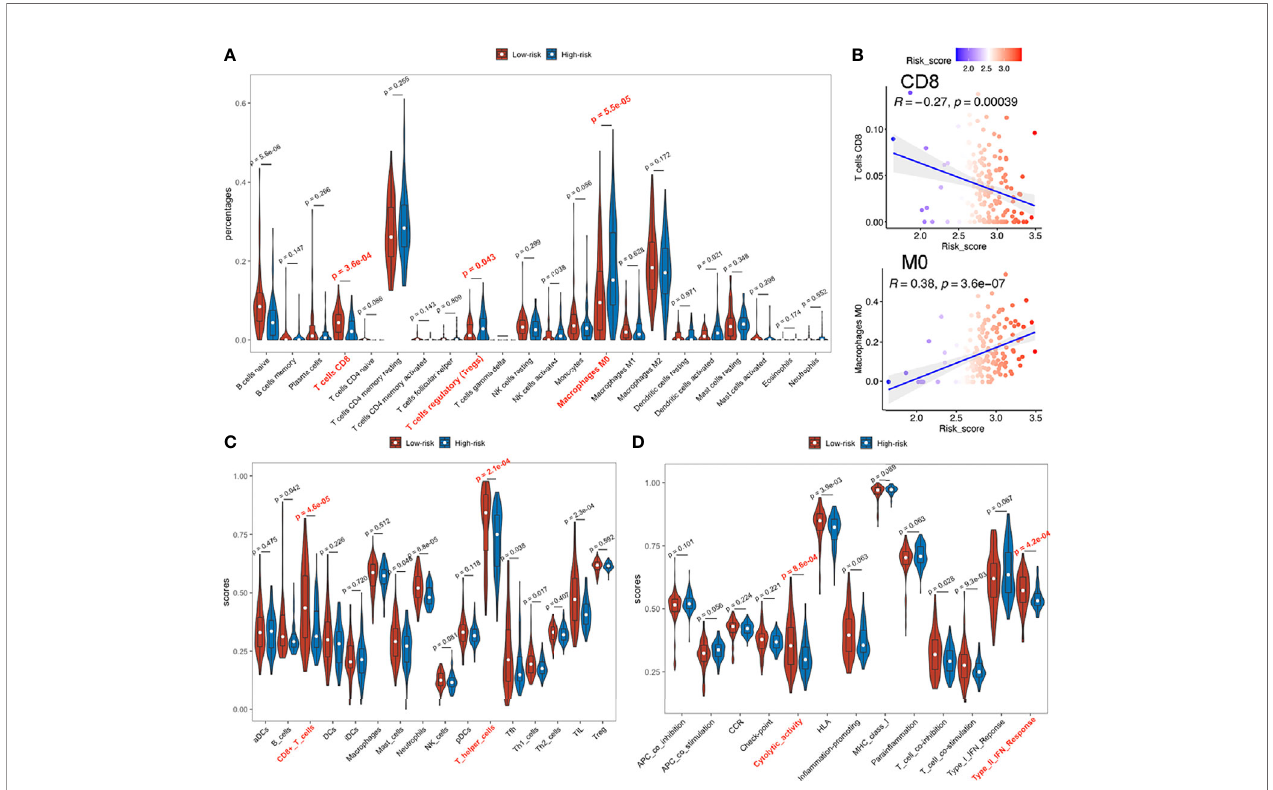
FIGURE 7 | Immune in fi ltration status of TCGA-PAAD dataset. (A) Abundances of 22 immune cells by CIBERSORT. (B) Upper: correlation between of CD8+ T cell in fi ltration with the signature; lower: correlation between M0 macrophage with the signature. (C, D) Immune cell in fi ltration analysis and immune function enrichment by